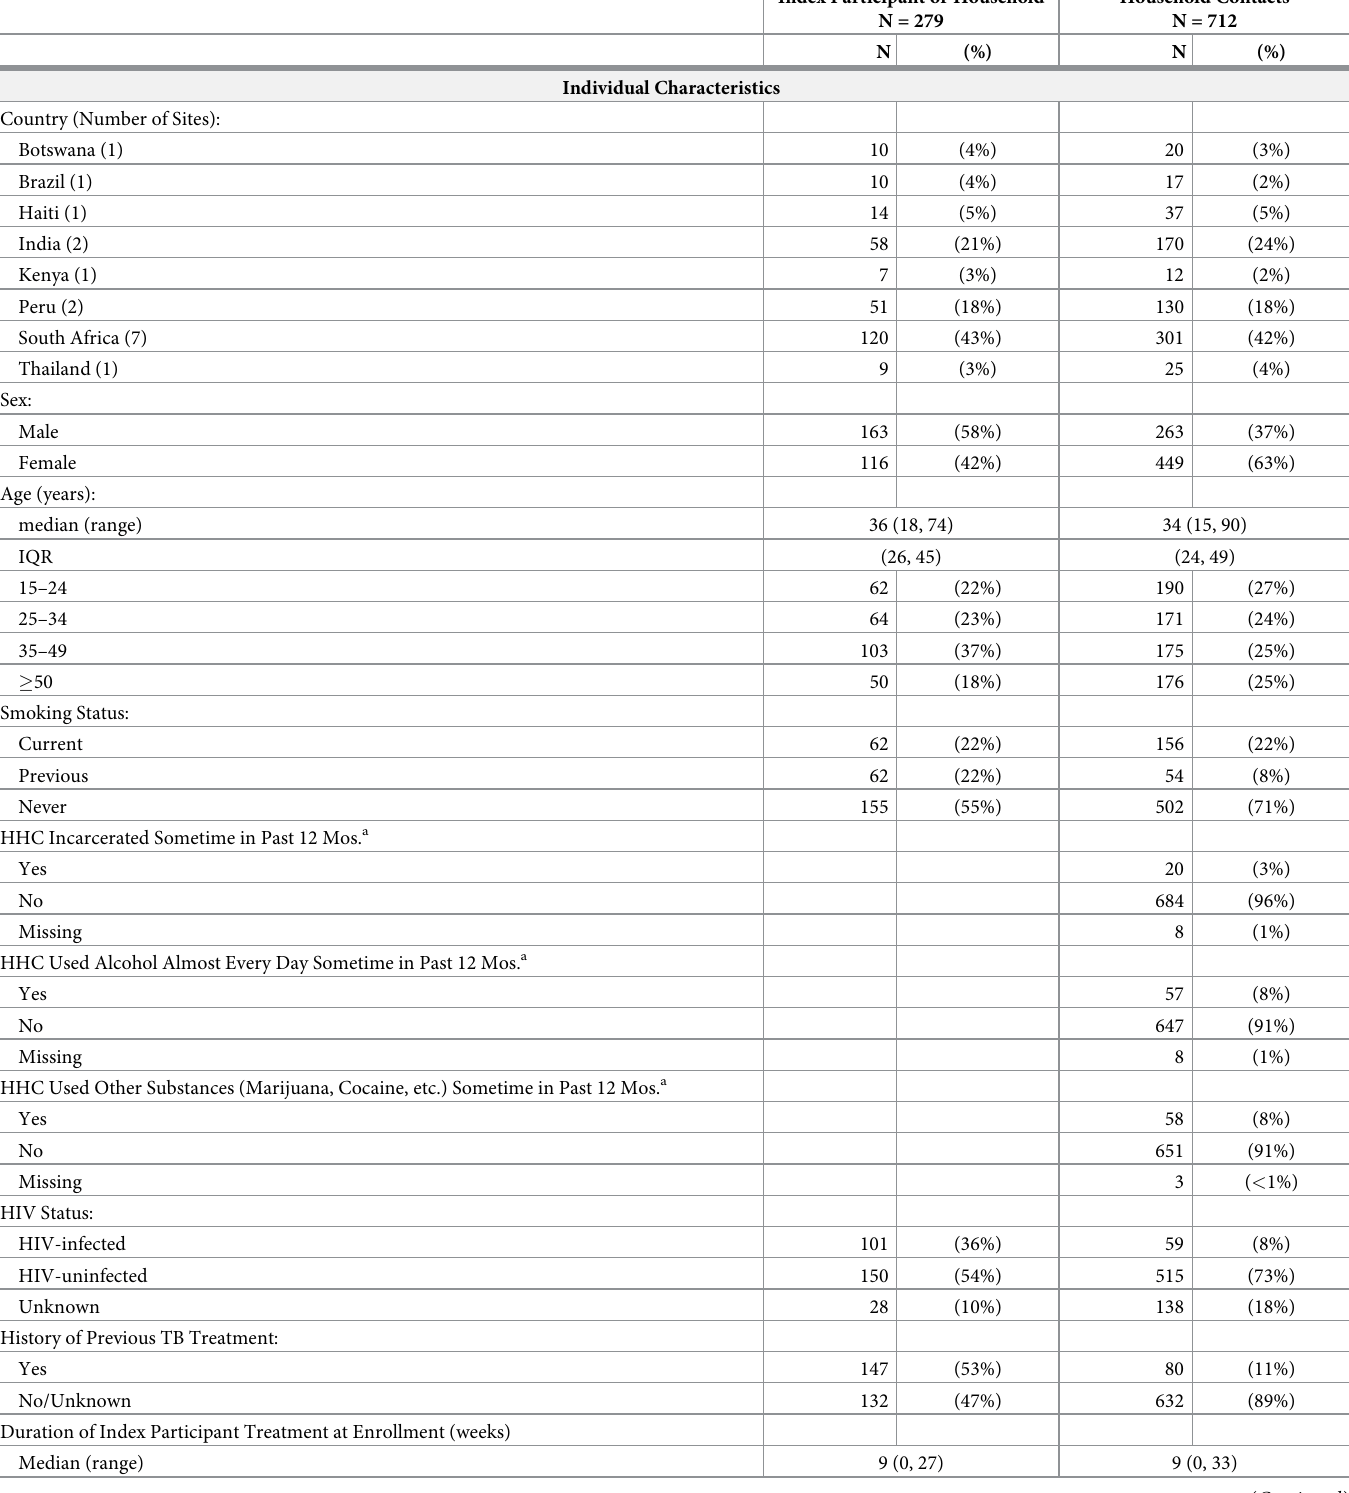
Table 1. Characteristics of household contacts � 15 years of age and of their index participants and households �